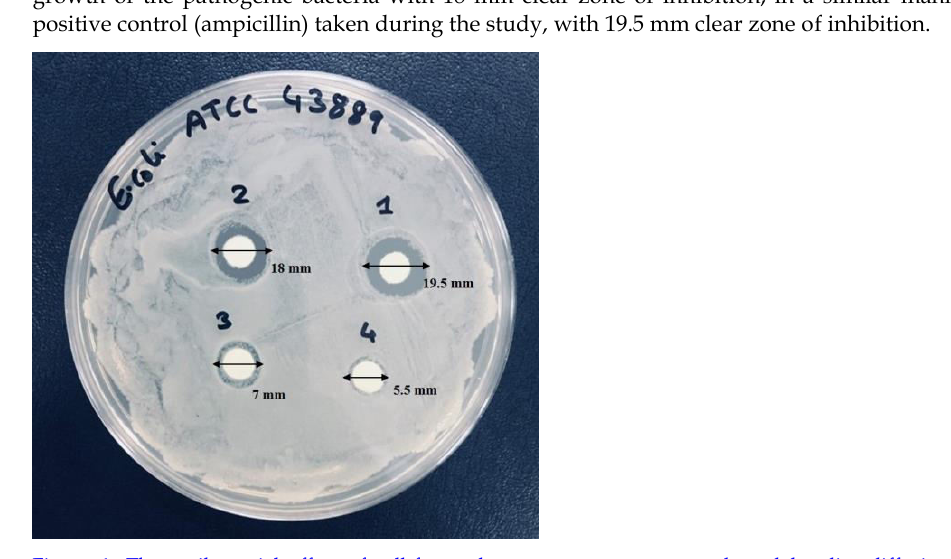
Figure 1: The antibacterial effect of cell-free culture supernatant was evaluated by disc diffusion method and compared with ampicillin on LB agar against E. coli 0157: H7. Ampicillin (100 µg/mL in Disc 1); cell-free culture supernatant (100 µg/mL in disc 2; 50 µg/mL in disc 3; 25 µg/mL in disc